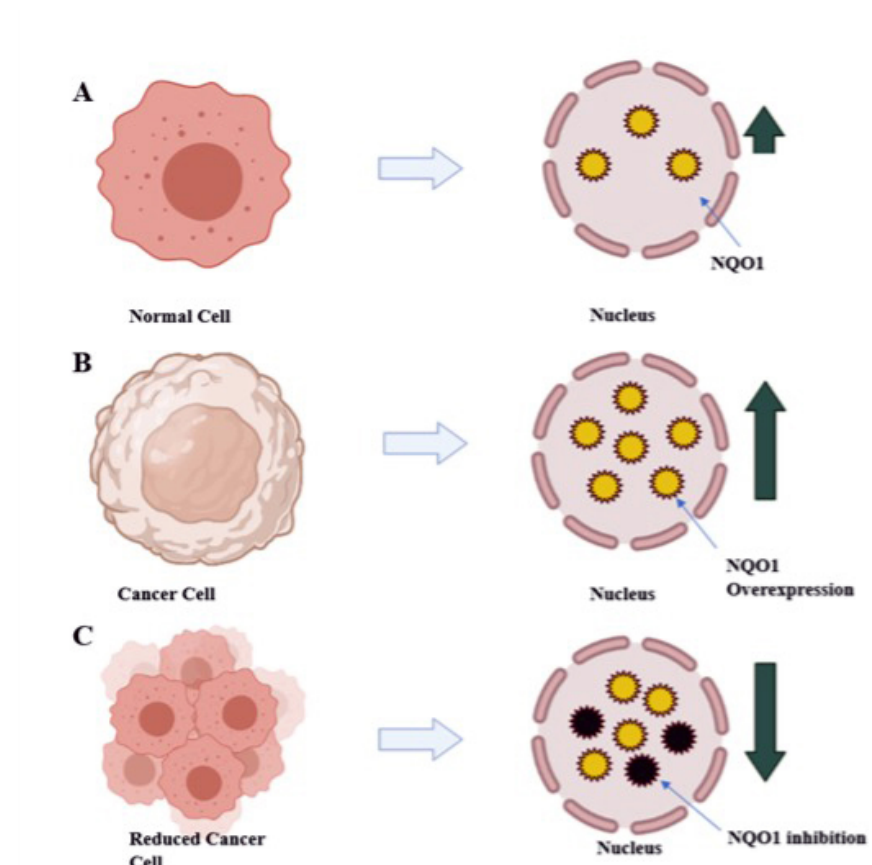
Figure 3. Diagrammatic representation of therapeutic approach with reduction of NQO1 levels in tumor cells results in decreased tumor burden: ( A ) normal liver expressing NQO1 (yellow circles) at normal level; ( B ) NQO1 (yellow circles) over expressed in tumor cells; ( C ) treating with anti- NQO1 drugs leads to the decreased tumor burden by decreased level of NQO1 (inhibited NQO1 black